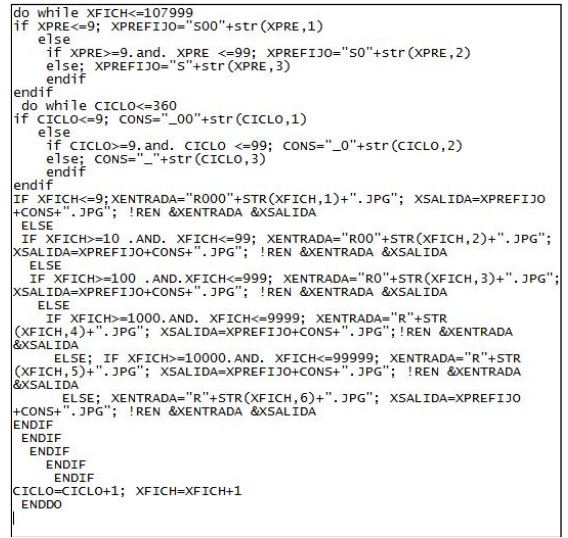
Figure. 7. Code for adapting multiple frames to the plugin Stitch Sequence of Grid of Image (J-Image software) The final video creation includes the removal of green backgrounds, the overlapping of both environment and animation sequences, and the transformation of the multiple single frames into continuous video format. This task can be conducted in almost any video editing software; for the purpose of this research, we used Sony Vega